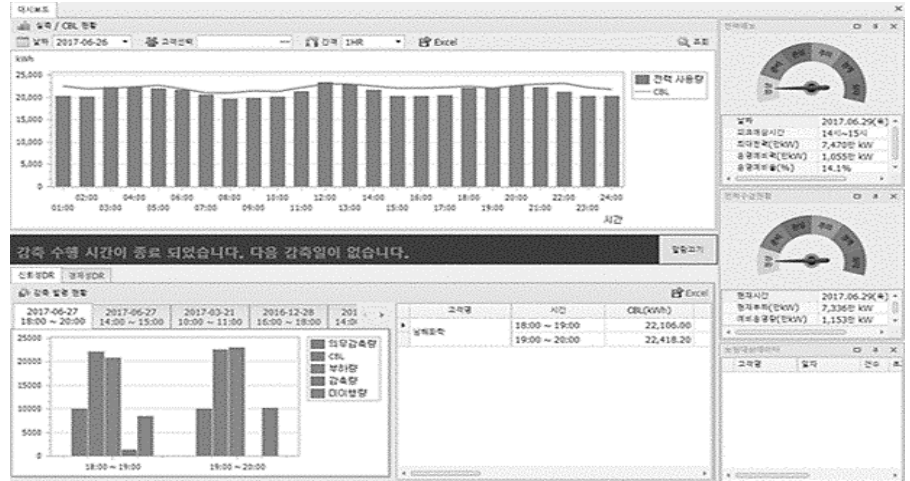
Figure 6. N company power consumption and baseline load.